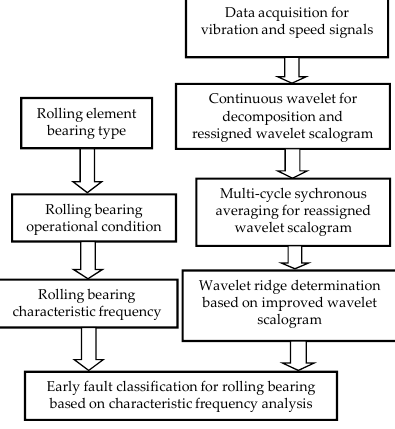
Figure 11. Flowchart for rolling element bearing fault diagnosis.